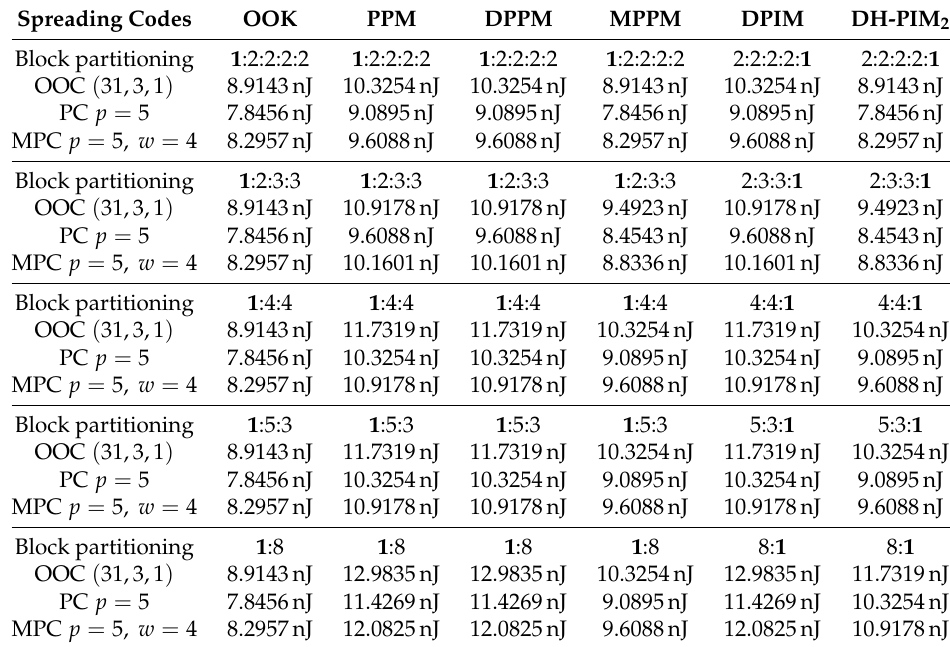
Table 13. Pulse peak power E TX as a combination of block partitioning, modulation, and spreading code. Spreading